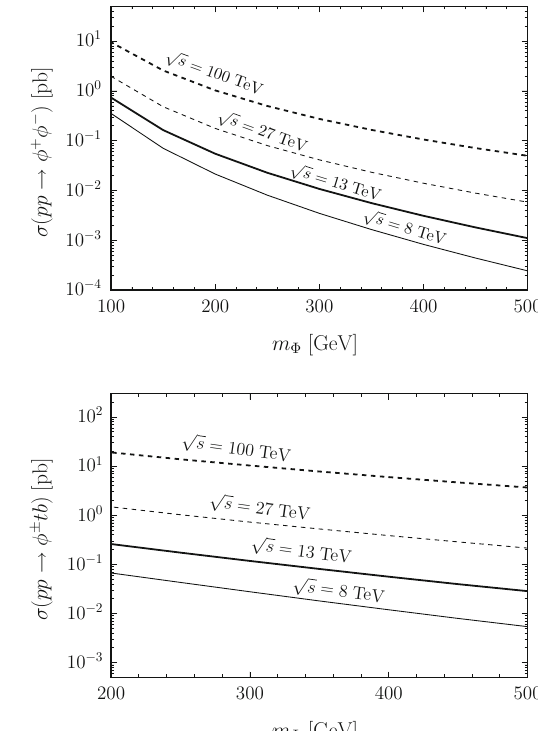
Fig. 7 Representative diagrams of the main (cid:2) production mechanisms at pp colliders. Left) Pair production via EW currents. Middle-left) Single production via gluon fusion. Middle-right) Production in association with tb ( tb ). Right) Production from the decay of a top quark